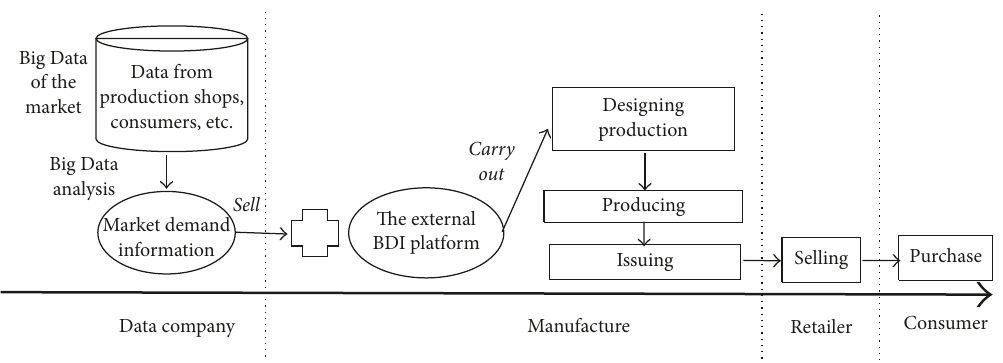
Figure 1: Application of Big Data in the traditional